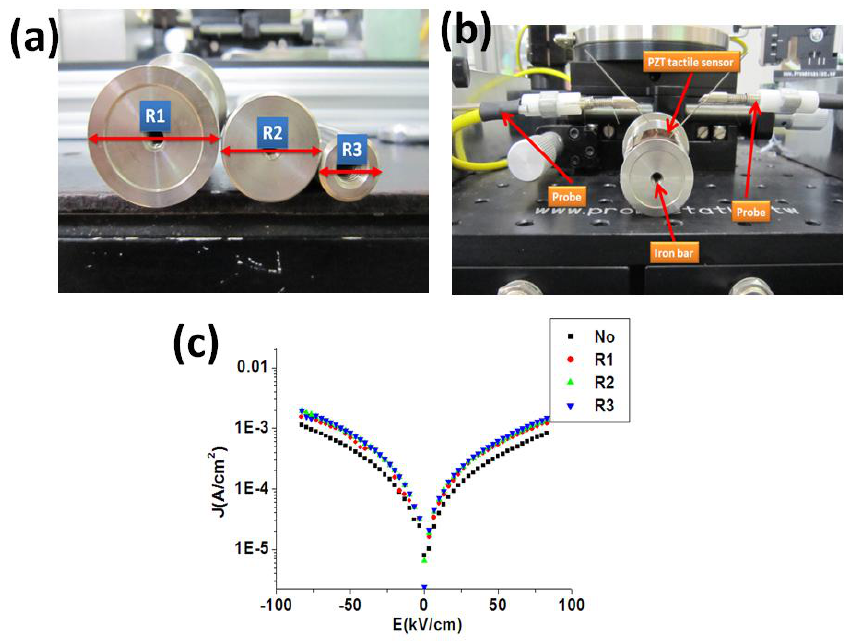
Figure 6. ( a ) Iron bars with different radius, ( b ) test set-up of our sensor flexibility testing, ( c ) J-E curves of our PZT sensor mounted without and with iron bars at different radius of